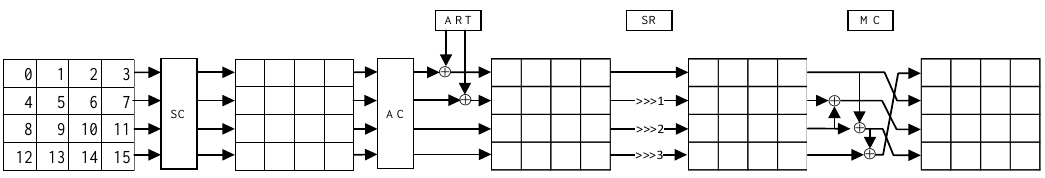
Figure 1. The SKINNY round function.